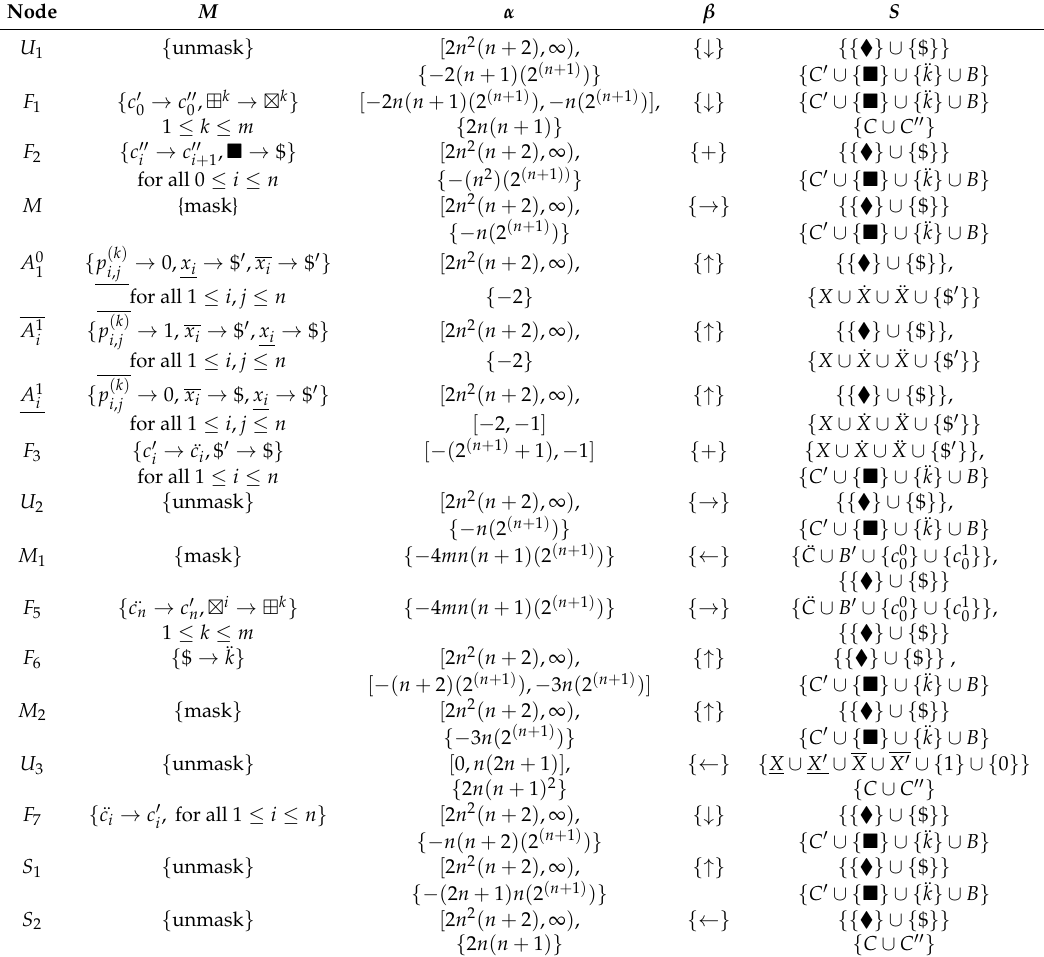
Table 4. Internals of the nodes of the subnetwork Eval 2 .